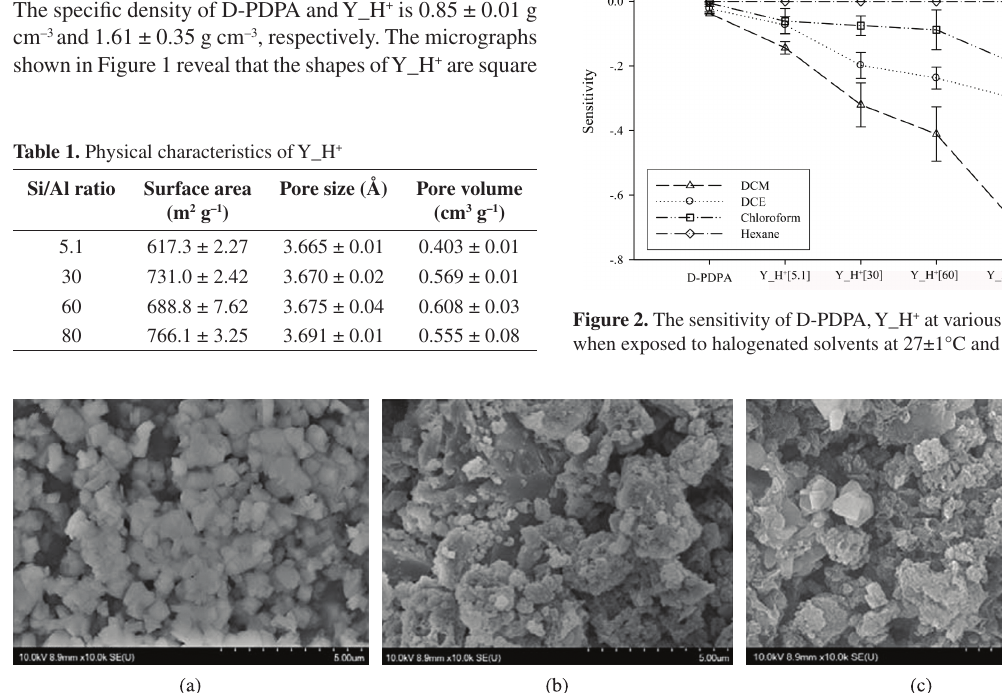
Figure 1. SEM micrographs at 10000x of: (a) Y_H + ; (b) D-PDPA; and (c) D-PDPA/Y_H + .